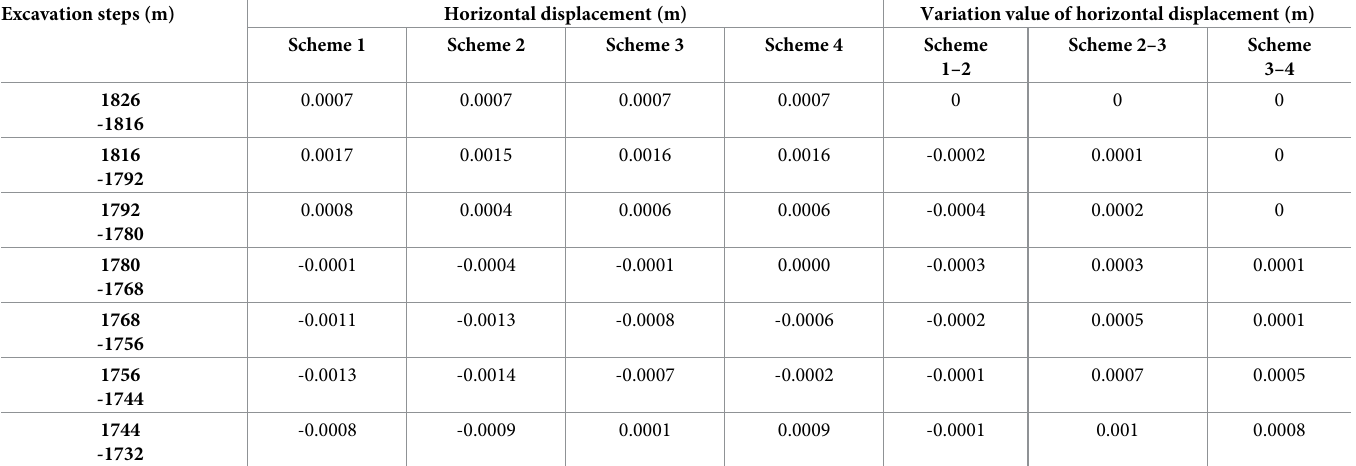
Table 4. Calculation of horizontal displacement of 1780-1768m stair under different excavation conditions. Excavation steps (m)